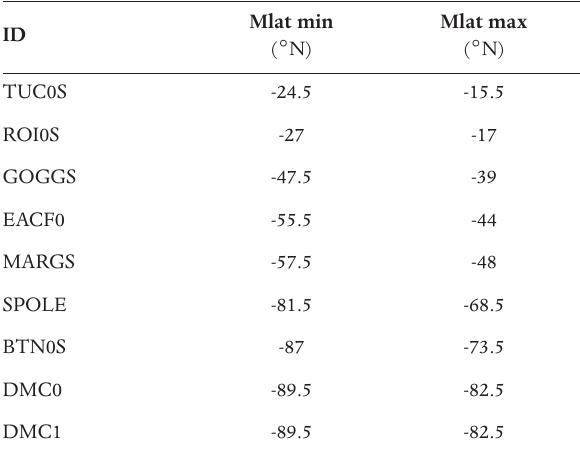
Table 3. Ranges of magnetic latitudes covered by each receiver.